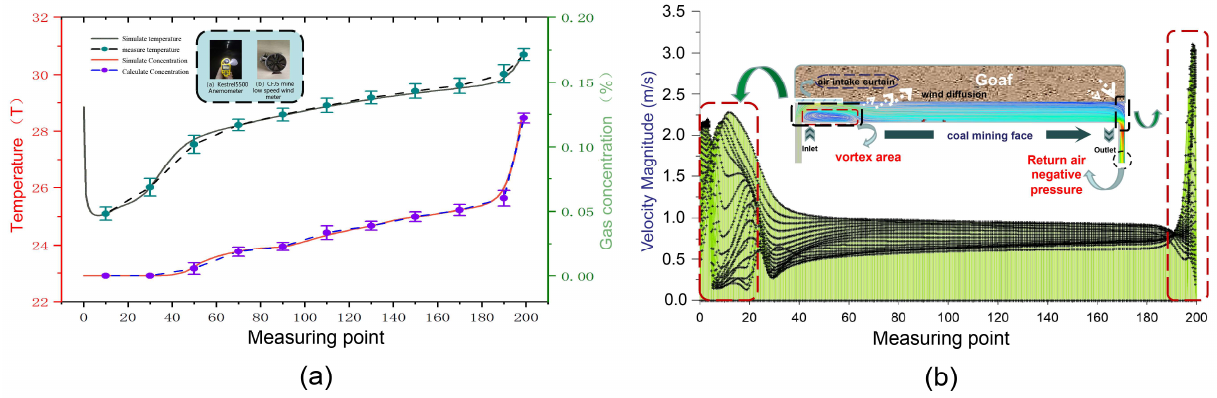
Figure 6. 3D comparison of calculated and measured theory. ( a ) Comparison between calculation and measurement; ( b ) Comparison between calculation and theory.